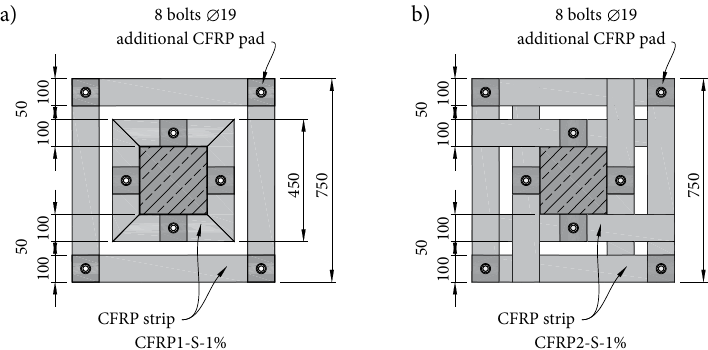
Figure 4. The method of strengthening of support zone considered in investigations (Ebead & Marzouk, 2004)